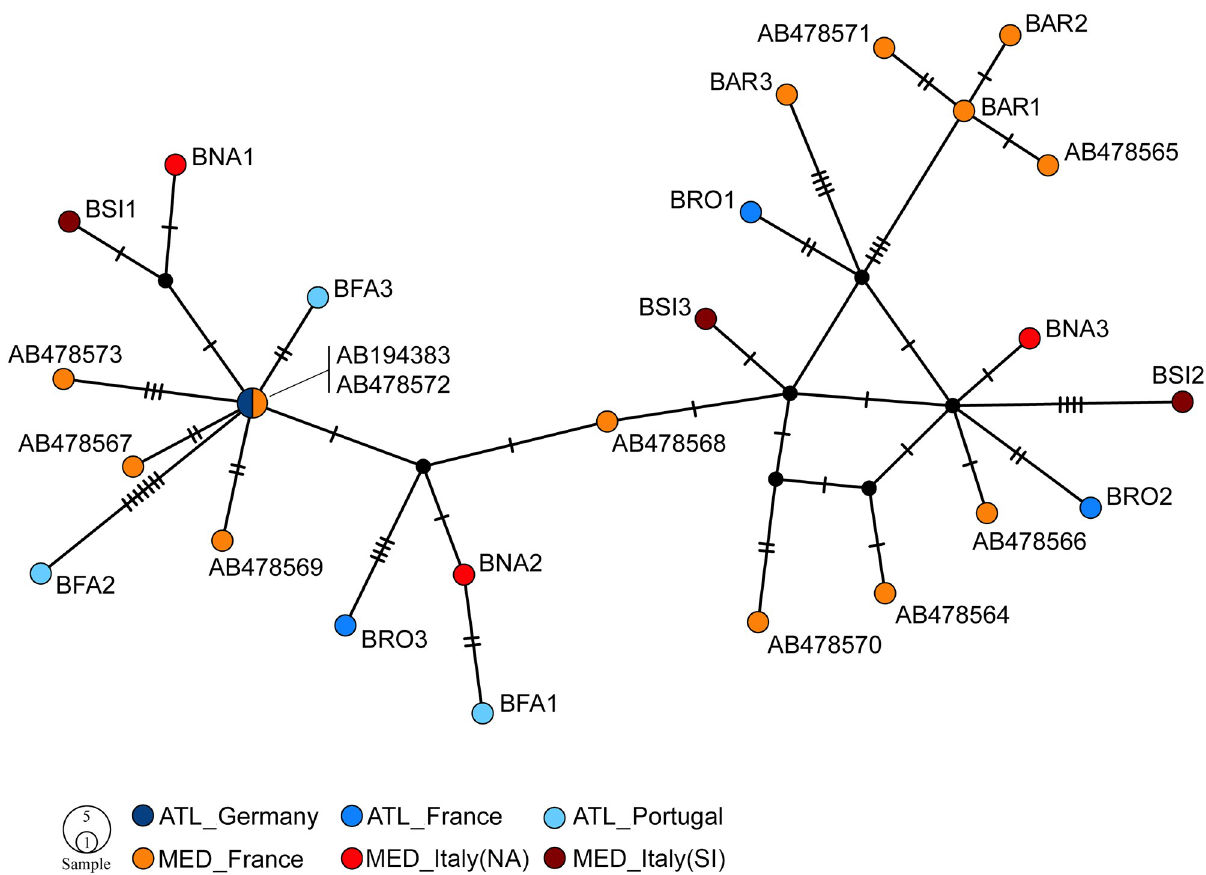
Fig 3. TCS for the concatenated matrix (COX1+12S+16S) of B . lanceolatum , showing relationships between the recorded haplotypes. See S1 Table for codes. Abbreviations used: ATL–Atlantic Ocean; MED–Mediterranean Sea; AR–Argel è s sur Mer; NA–Napoli; SI–Siracusa. Circles representing haplotypes are scaled to their frequencies. Black dots represent missing intermediate haplotypes. Branch length connecting the different haplotypes is proportional to the number of mutations, with small transversal lines along the connecting branches representing mutational steps.